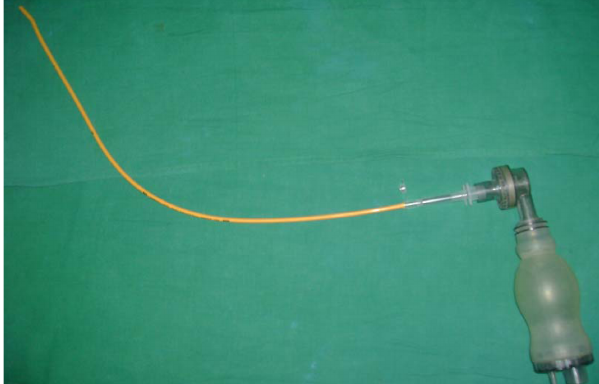
Figure 1 - Adaptor for trans-tracheal ventilation.